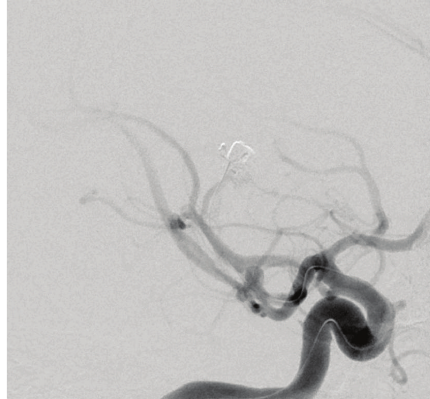
Figure 5: Intraprocedurecerebral angiogram demonstrating micro- catheter tip placement within the fusiform aneurysm and Onyx embolization completion.